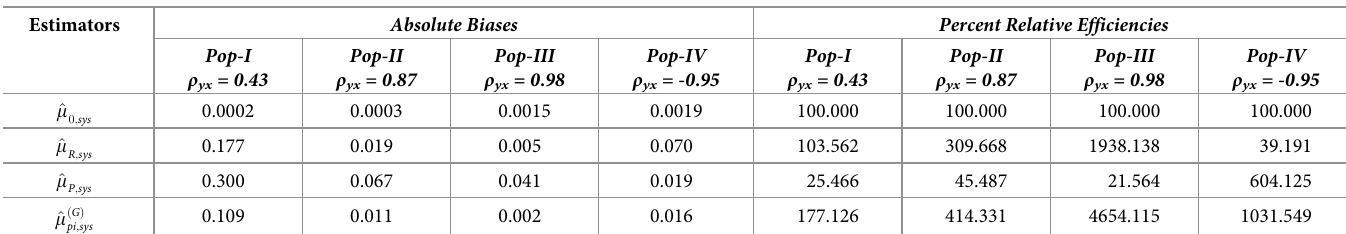
Table 2. The amount of ABs and PREs of different estimators.